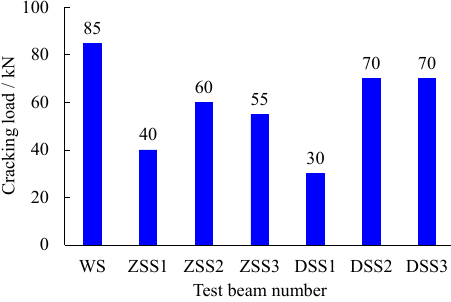
Figure 11. Cracking load of test beams.